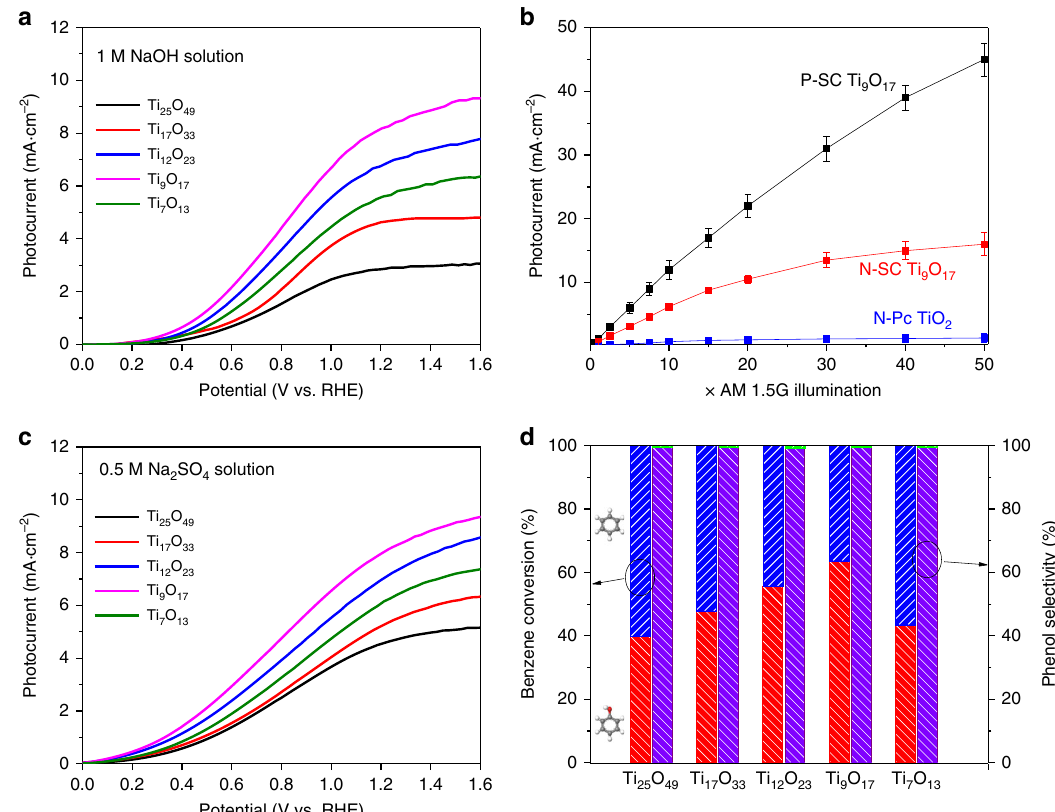
Fig. 6 Photoelectrochemical performance of porous single-crystalline (P-SC) Ti n O 2 n − 1 . a Linear Scanning Voltammetry (LSV) of P-SC Ti n O 2n-1 photoanodes for water oxidation using a three electrode setup (Ti n O 2 n − 1 working, Pt counter, Hg/Hg 2 Cl 2 reference electrode, scan rate of 20 mv s − 1 ) in a 1 M NaOH electrolyte (PH = 13.6). b Enhancement of photocurrent with increasing light intensity up to 50 AM1.5 G sunlight using P-SC Ti 9 O 17 , nonporous single crystalline (N-SC) Ti 9 O 17 and nonporous polycrystalline (N-PC) TiO 2 electrodes harvested at 1.23 V applied bias. Error bars represent standard deviation in repeated measurements. c LSV of P-SC Ti n O 2 n − 1 photoanodes for the oxidation of benzene under 10 AM1.5 G illumination. d Benzene conversion